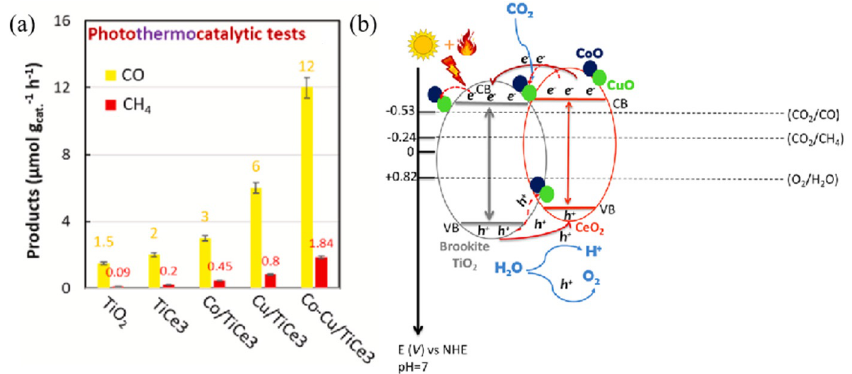
Figure 11. ( a ) Photothermal catalytic performances at T = 120 °C on the TiO 2 -CeO 2 -based samples. ( b ) Photothermal catalytic mechanism with the CoO-CuO/TiO 2 -CeO 2 catalyst (Reprinted/adapted with permission from Ref. [89]. Copyright 2022, copyright Elsevier).